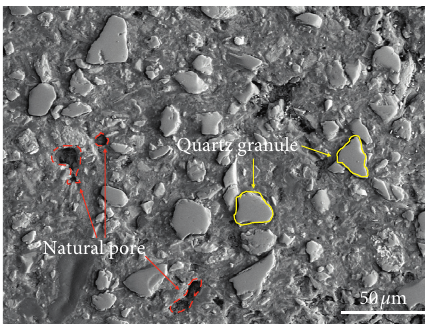
Figure 8: Original scanning electron microscope image of un- disturbed loess (magnified